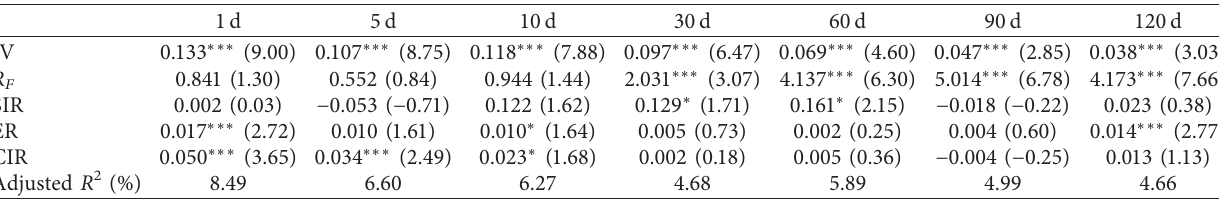
Table 3: Short-term forecasting power of IV on stock market